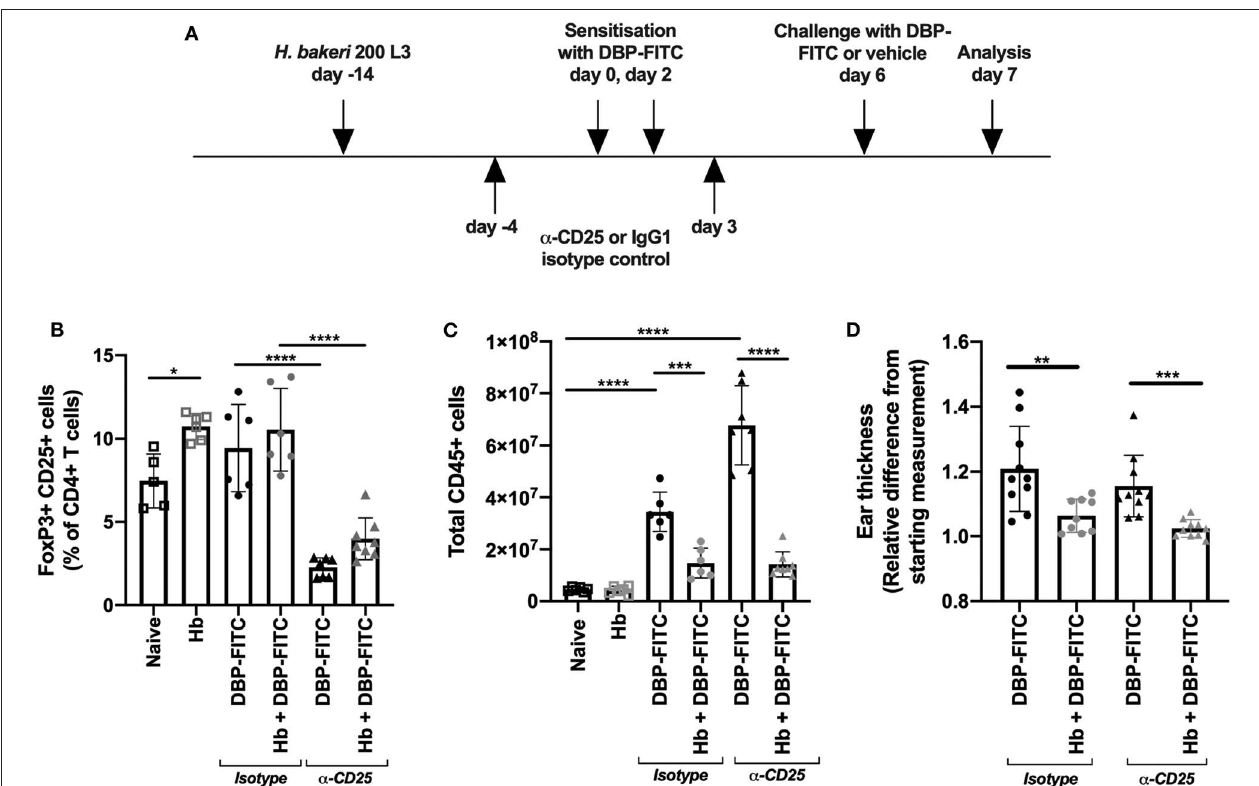
FIGURE 2 | Anti-CD25 depletion of H. bakeri- induced Tregs does not affect reduction of LN hyperplasia after DBP-FITC challenge. (A) Timeline of DBP-FITC topical application model including treatment with anti-CD25 or isotype control. (B) Frequency of FoxP3 + CD25 + cells within the CD4 + T cell compartment at day 7 in the ear dLN. (C) Total number of live CD45 + cells from the ear dLN at day 7. (D) Relative difference in ear thickness at day 7 after DBP-FITC challenge in mice with or without Hb infection, treated with anti-CD25 or an isotype control. A one-way ANOVA with Tuckey’s multiple comparisons test was used to test statistical significance. Graphs represent data combined from 2 experiments and show mean ± SD. n.s, not significant; * p < 0.05, ** p < 0.01, *** p < 0.001, **** p < 0.0001.